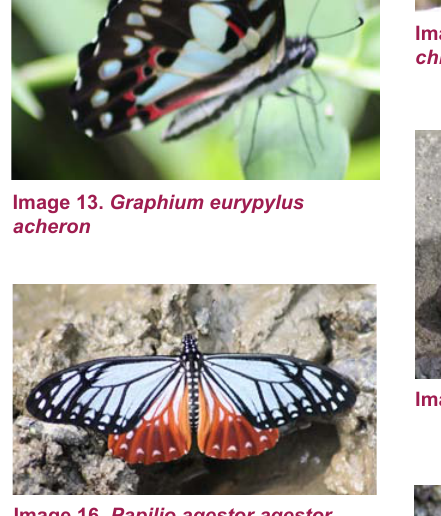
Image 16. Papilio agestor agestor